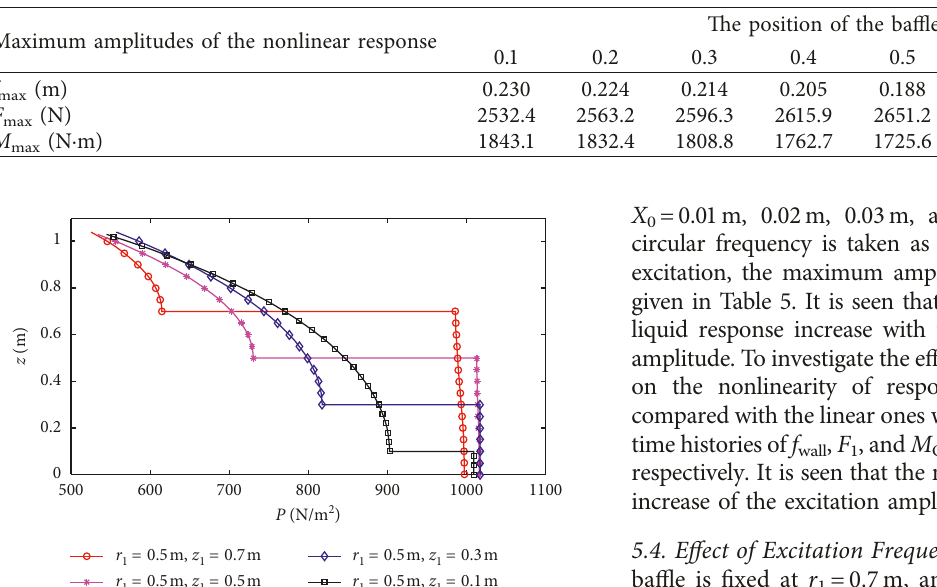
� 0.5m and z � 0 . 1 m and M for r max max 1 1